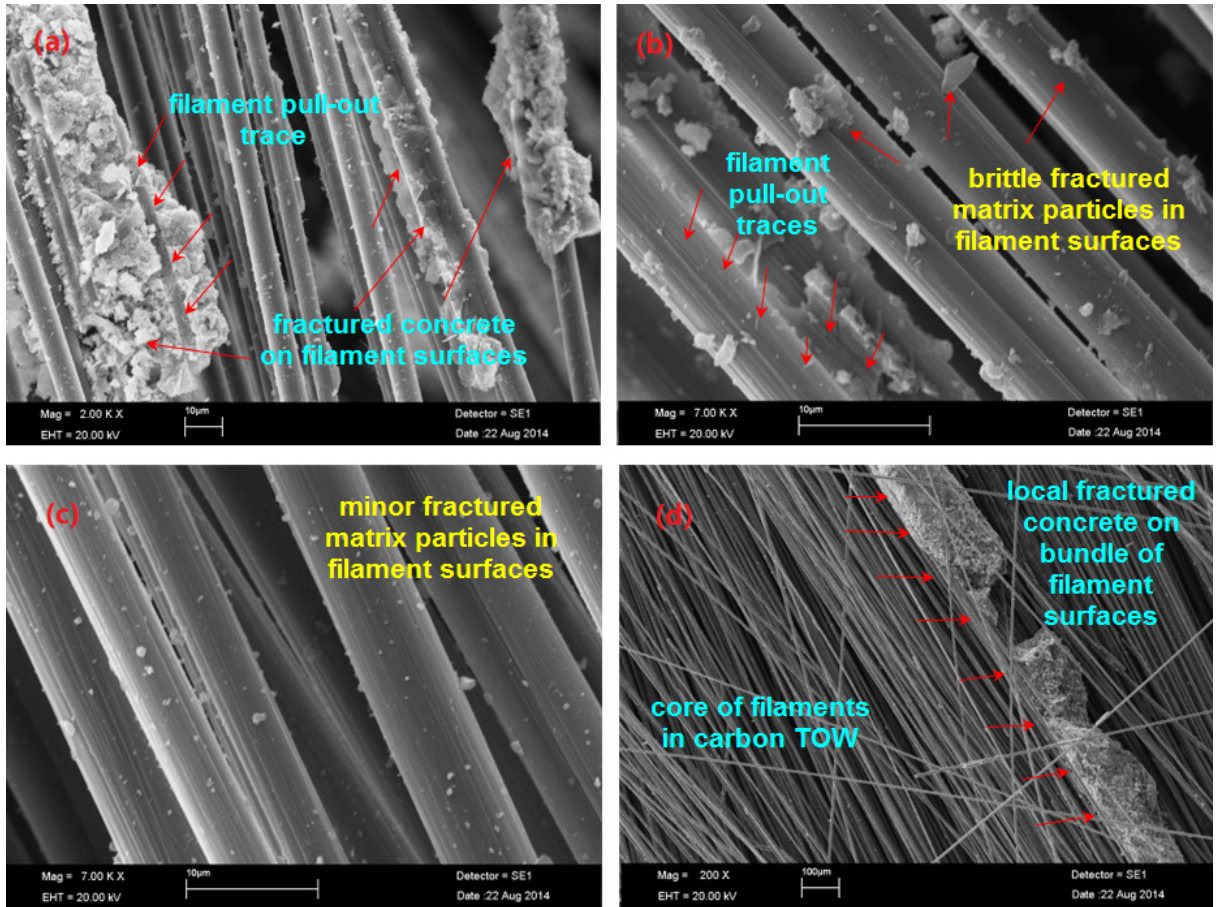
Figure 23. SEM graph of fractured samples. ( a ) Failed surface of the carbon warp (0°) in the C-4D; ( b ) enlarged view of the failed fiber-cementitious matrix in carbon filling (90°) in C-4D; ( c ) fractured matrix in bias fiber (+45°) in C-4D; ( d ) fractured matrix in the bias fiber ( − 45°) in the C-4D concrete.